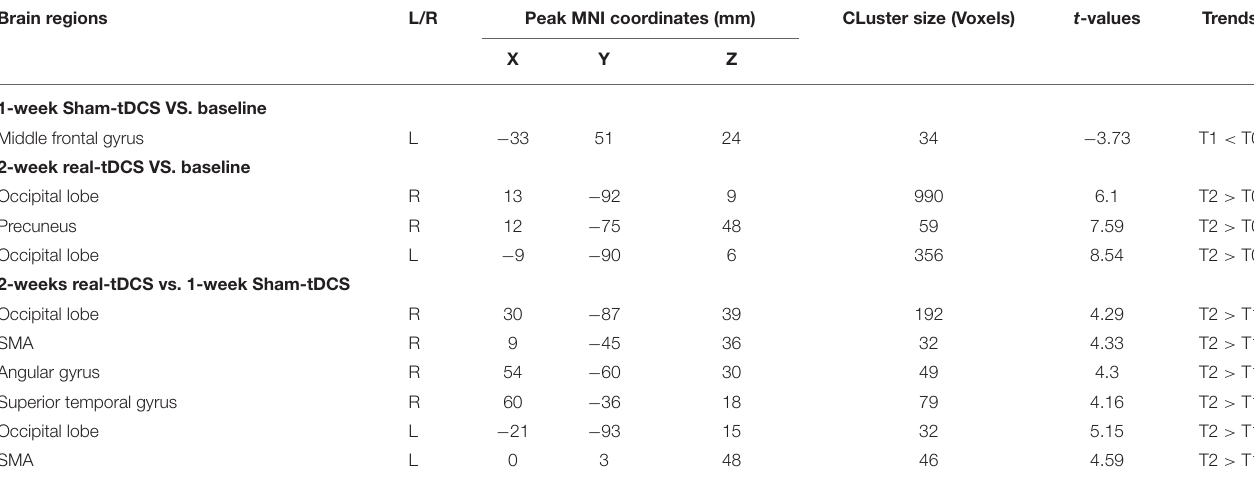
TABLE 3 | Brain regions with alteration of functional connectivity (FC) after different transcranial direct current stimulation (tDCS) protocols. Brain regions L/R Peak MNI coordinates (mm) CLuster size (Voxels) t -values Trends X Y Z 1-week Sham-tDCS VS. baseline Middle frontal gyrus L 2-week real-tDCS VS.